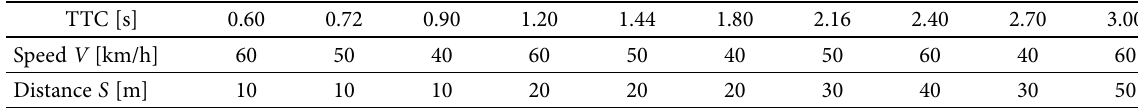
Table 1. Realised parameters of particular tests